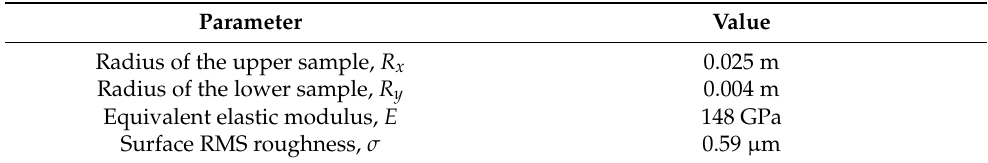
Table 1. Parameters of the